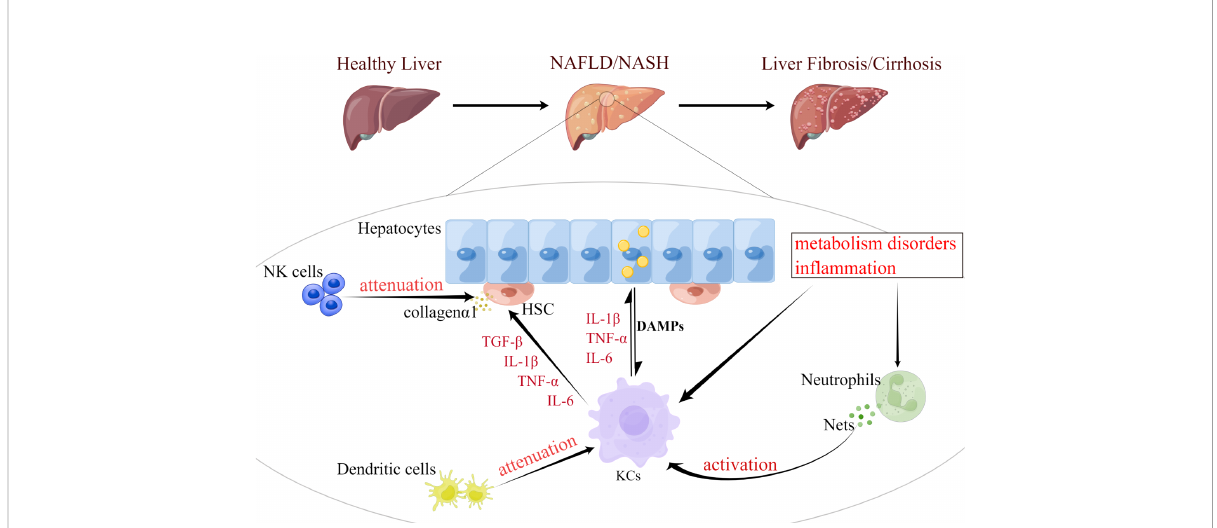
FIGURE 2 Functional changes of innate immune cells are involved in the progression of NAFLD. NAFLD progression occurs in parallel with metabolic and in fl ammatory derangements that promote the activation and aggregation of innate immune cells (e.g., KCs, neutrophils, DCs, and NK cells). During the development of NASH, KCs can be activated by excessive fat load in hepatocytes, dysregulated hepatic metabolism or in fl ammation. Fat overload in hepatocytes induces the release of lipotoxic and DAMP, activating KCs and HSC, thereby promoting in fl ammation and fi brosis. Neutrophils induce metabolic in fl ammation in the liver by releasing high levels of granulins, forming NETs, and activating KCs. DCs can also activate KCs and activated KCs can exacerbate hepatocyte steatosis by secreting cytokines, such as IL-1 b , TNF- a , and IL-6. Meanwhile, both KCs and NK cells promote the activation and survival of HSC, which trigger their release of collagen 1, as well as the development of liver in fl ammation and fi brosis. KCs, Kupffer cell; DCs, dendritic cell; HSC, hepatic stellate cell; NK cell, natural killer cell; DAMP, damage-associated molecular patterns; NETs, neutrophil extracellular traps; IL-1 b , interleukin 1 beta; TNF- a , tumor necrosis factor